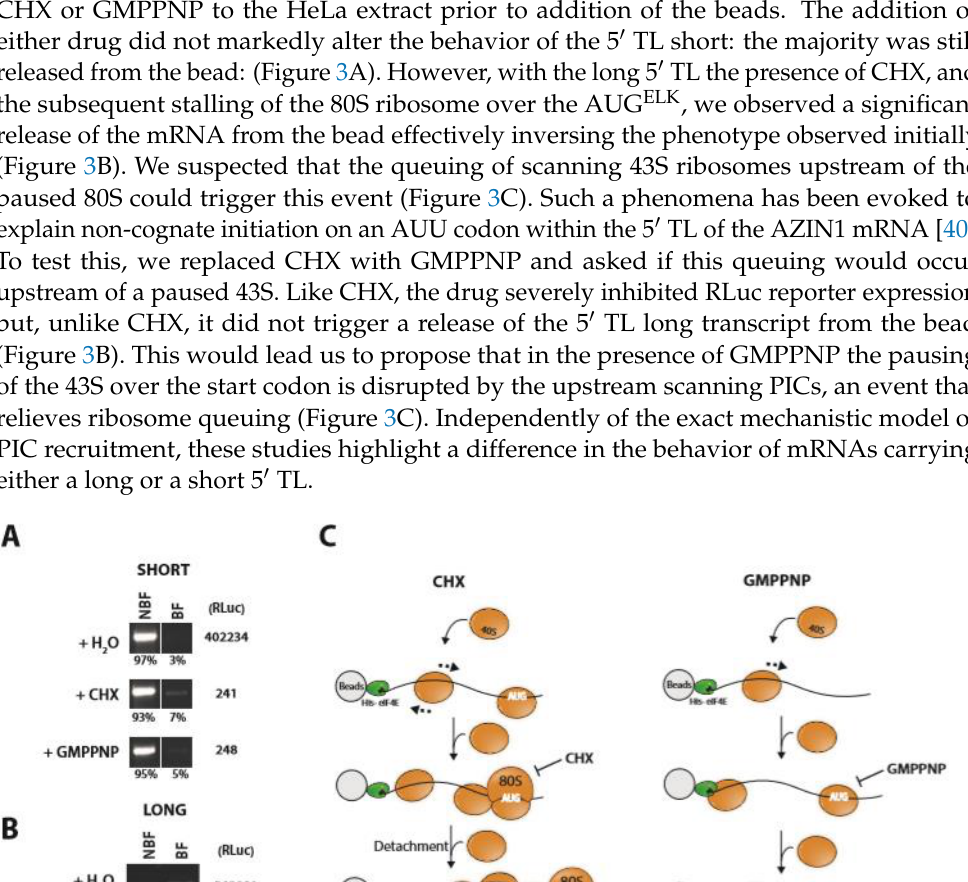
linear range. ( E ) A representative RT-PCR analysis of the NBF and BF fractions after incubation in cell extracts. The measured RLuc activity in the cell extract (arbitrary units) is indicated below each panel. Bands were quantitated using the BIO-RAD image-lab software. The experiment was repeated four times and the results are indicated in the lower panel as the % of RNA retained on the bead (BF/(BF + NBF) × 100). The horizontal bar indicates the mean from these experiments. ( F ) Left hand panel: One µ g and 2 µ g of His eIF4E was immobilized on HIS-Dynabeads. As a negative control, the beads were incubated with 2 µ g of BSA. They were then added to a cell extract, recovered, and washed twice (see Section 3) before adding protein sample buffer. Proteins were analyzed on immunoblots using ant-eIF4E and anti-eIF4G Abs. Right hand panel: Translation reactions were performed as above. NBF and BF fractions were recovered and the distribution of the HIS eIF4E protein was monitored by immunoblot. *** p < 0.001.